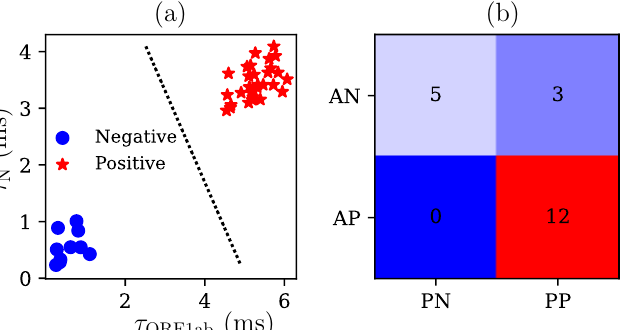
Figure 5. Classification results for SARS-CoV-2 genome detection. ( a ) Linear model for the training data set based on logistic regression. ( b ) Confusion matrix describing the classifier performance in prediction, of which the accuracy is